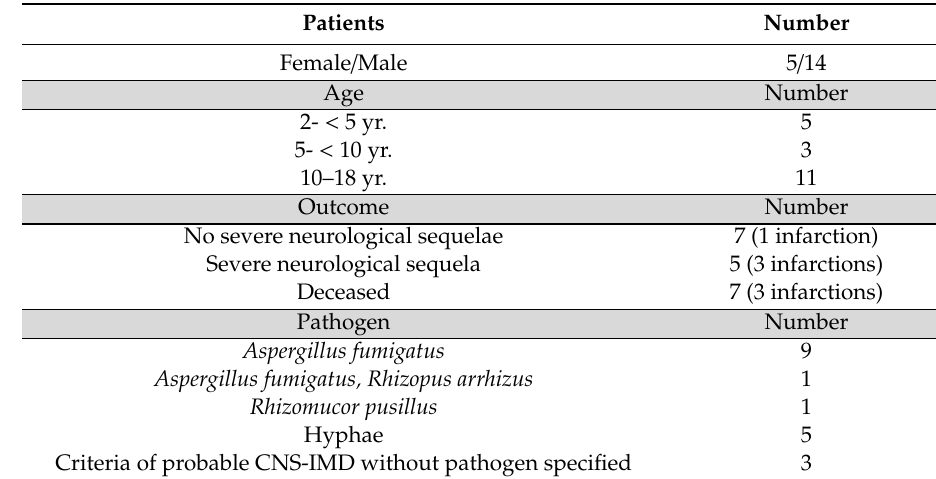
Table 1. Patient demographics and outcome.